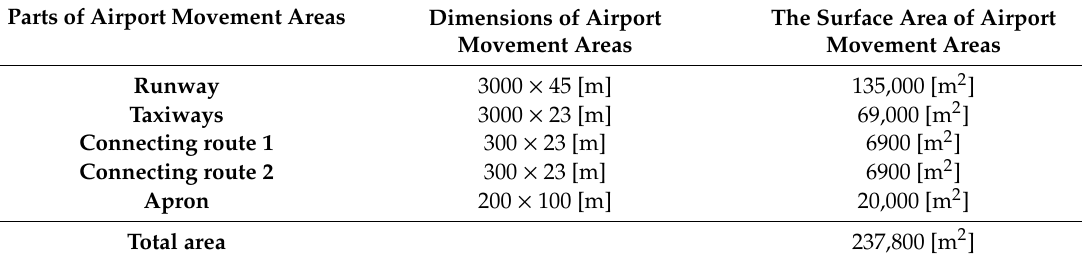
Table 2. Basic dimensions of Kosice Airport, Inc.